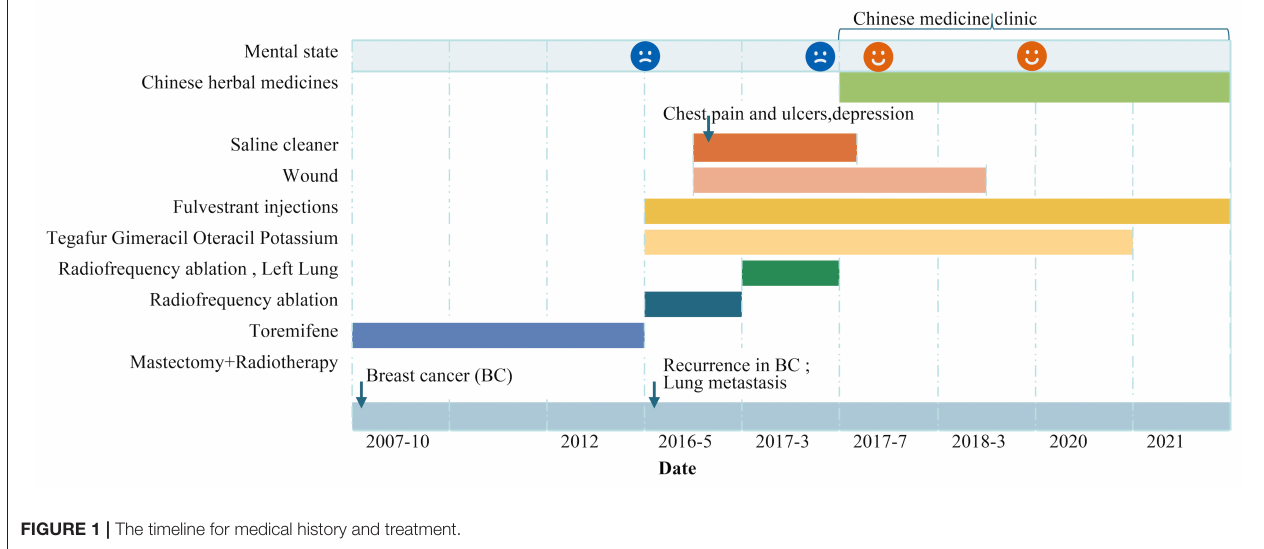
FIGURE 1 | The timeline for medical history and treatment.